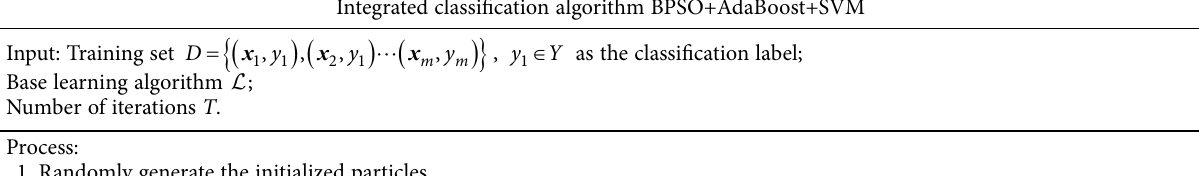
Table 8. BPSO+AdaBoost+SVM algorithmic process Integrated classification algorithm